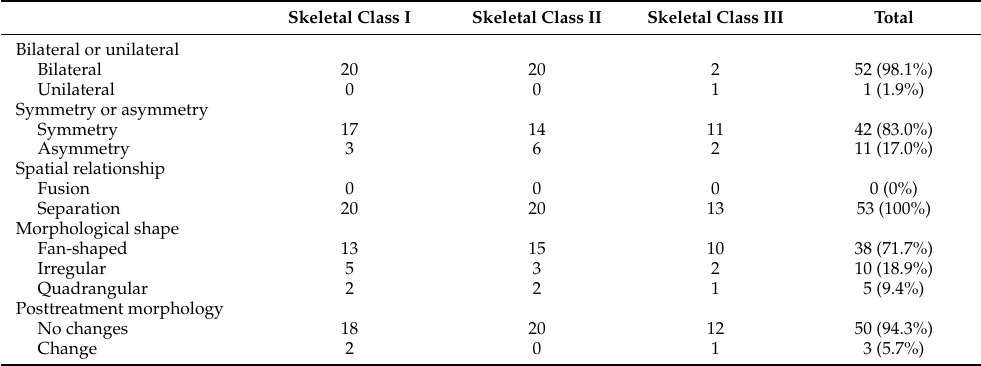
Table 2. Morphological features of the frontal